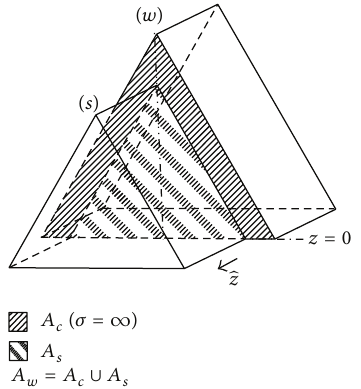
Figure 4: Step between equilateral triangular waveguides.